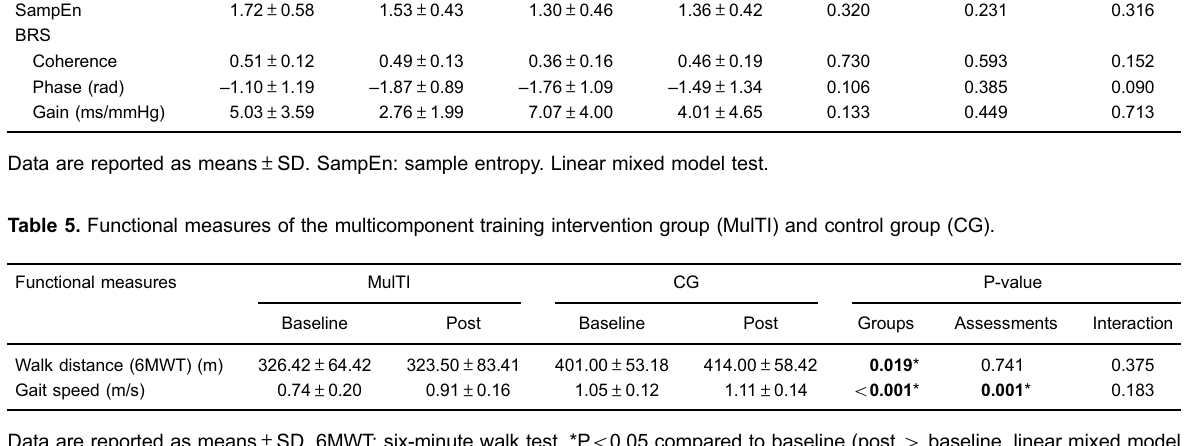
Table 4. SampEn and barore fl ex sensitivity (BRS) in multicomponent training intervention group. Baseline Post Supine Orthostatic Supine Orthostatic Position SampEn